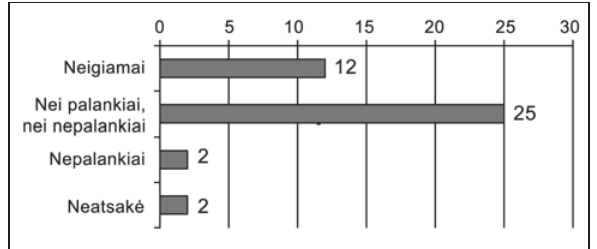
14 pav. Dabartinës teritorijø planavimo sistemos ir praktikos vertinimas pagal ekspertø apklausos rezultatus 2005 m. Fig 14 . Assessment of the present territory planning system and practice according to the experts’ poll results, 2005